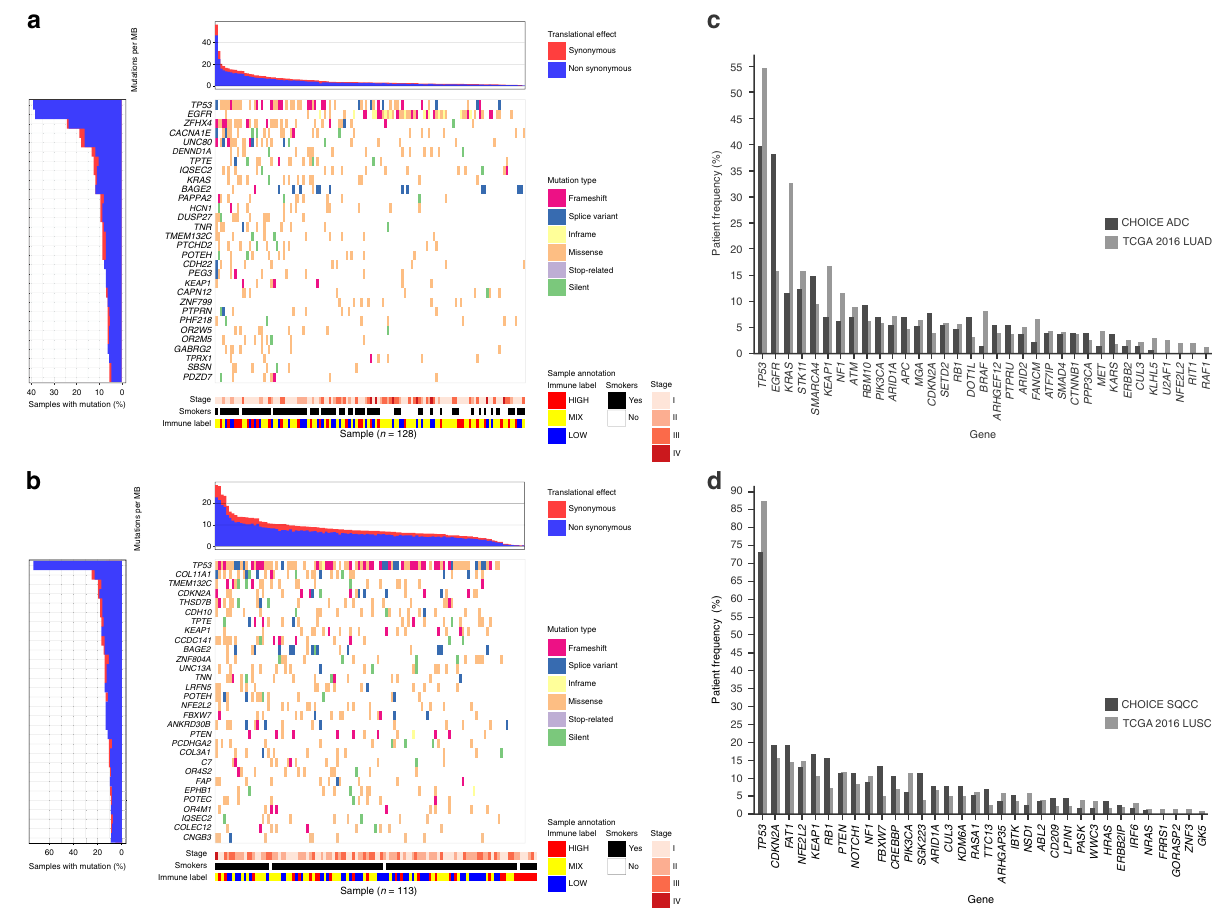
Fig. 2 Signi fi cantly mutated genes for ADC and SQCC in the CHOICE study. a Top 30 signi fi cantly mutated genes in ADC, samples were ordered based on their somatic non-synonymous mutation burden (top panel) and genes were ranked by mutation frequencies (left panel). Cancer stage, smoker status, and immune in fi ltration status are annotated in the bottom panel. b Top 30 signi fi cantly mutated genes in SQCC. Comparison of the mutation frequencies of signi fi cantly mutated gene between the CHOICE and TCGA study in ADC ( c ) and SQCC ( d ). Source data are provided as a Source Data fi Tumor-in fi ltrating lymphocyte enrichment pro fi le in NSCLC . investigated for ADC and SQCC. The ssGSEA based signature Enrichment of gene signatures for different immune cell types in score of 26 immune cell types were used to cluster ADC (Fig. 4a) adaptive and innate immunity, as well as gene signatures for and SQCC (Fig. 4b) into 3 immune status (online methods): antigen presenting machinery (APM), cytotoxic cell and angio- HIGH, patients having high ssGSEA scores of the various genesis were examined using single-sample Gene Set Enrichment immune cell types; MIX, a mixture of high and low ssGSEA Analysis (ssGSEA). Tumor-in fi ltrating lymphocytes (TILs) were scores of the 26 immune cell types; and LOW, low ssGSEA scores of the 26 immune cell types. As expected, in both ADC and SQCC, patients with high immune marker gene expression values ( IFNG, PD-L1, PD-1, and CD8 ) were enriched in immune HIGH population (Fig. 4a, b). Mutation load was not signi fi cantly associated with different immune status in both ADC and SQCC patient cohorts. When looking at mutation/ampli fi cation differ- ence in ADC, immune HIGH tumors showed enrichment of KRAS mutation/ampli fi cation compared with the rest of ADC patients (immune MIX and LOW, Fisher ’ s exact test p = 0.0002). An opposite trend was observed for EGFR mutation (Fisher ’ s exact test p = 0.015, Supplementary Fig. 6a). STK11 mutations were found to be associated with the relatively low level of PD-1, PD-L1, T-cells signatures and elevated level of neutrophils sig- nature. However, the correlation is not signi fi cant except for T- cells ( t -test p = 0.01, Supplementary Fig. 7). It has been reported that STK11 de fi ciency can promote neutrophil recruitment and suppress T cell functions through the production of pro- in fl ammatory cytokines 16 . While in SQCC, immune MIX and LOW groups showed enrichment for ampli fi cation of TP63 ,